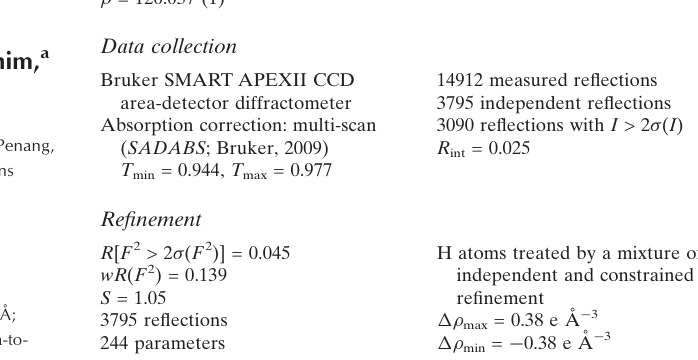
Bruker SMART APEXII CCD area-detector diffractometer Absorption correction: multi-scan ( SADABS ; Bruker, 2009)